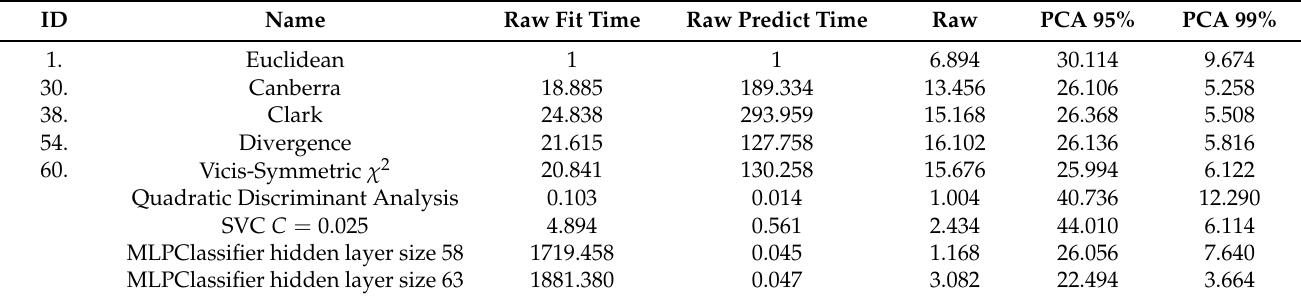
Table 1. Times for fitting mapping functions (Raw Fit time) and predicting times of test data (Raw Predict time) are relative to times for NN classifier with Euclidean distance. All values were averaged over the five runs. Misclassification rates are given for classification based on raw IMS data and based on PCA-transformed data explaining 95% and 99% of the total variance in the raw data. Large relative times for Canberra, Clark, Divergence, Vicis-Symmetric χ 2 are due to their implementations. Results for other distance measures and classifiers can be found in the Supplementary